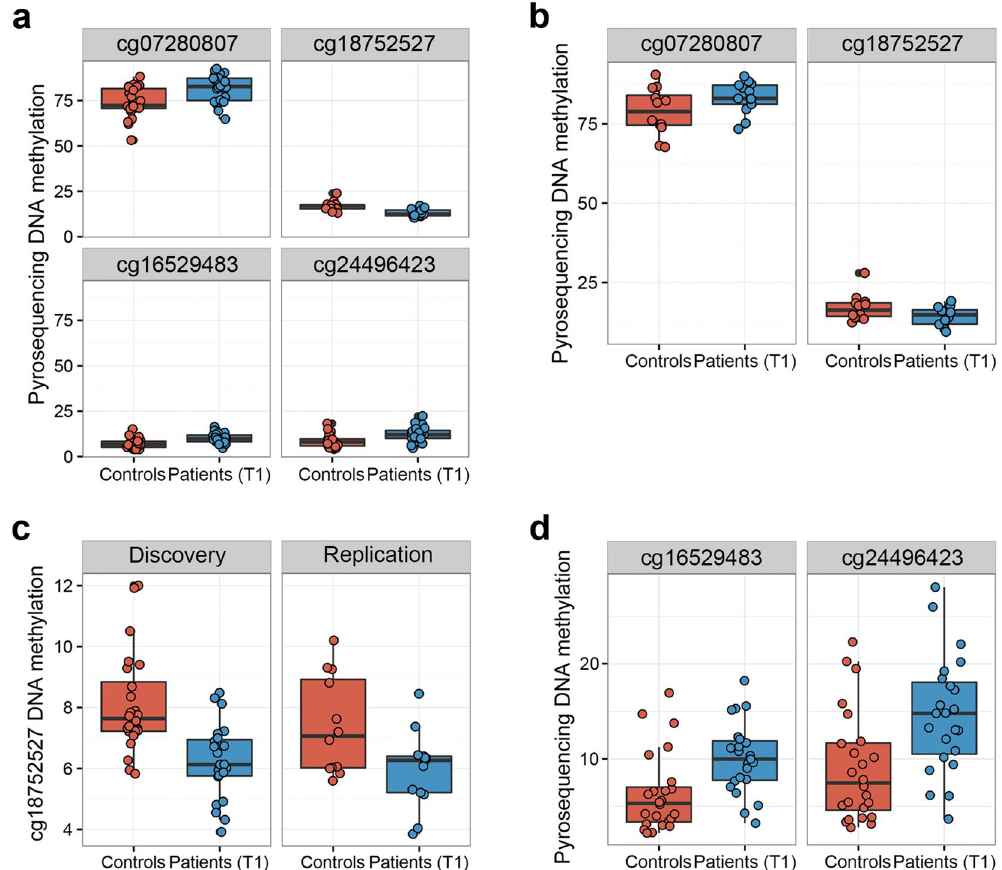
Figure 3. Validation and replication of top-ranking hits by pyrosequencing. ( a ) Boxplots showing differences in DNAm levels of discovery cohort T-cell samples as measured by pyrosequencing (FDR < 0.01, Student’s t-test). ( b ) Two top-ranked hits (cg07280807 and cg18752527) were verified as being differentially methylated in T-cell samples of the replication cohort (FDR < 0.05, one-sided t-test). ( c ) Verification of differential methylation of cg18752527 ( HECW2 ) in the discovery (left) and the replication cohort (right) in DNA derived from whole blood (FDR < 0.05, two-sided t-test). ( d ) Verification of cg16529483 and cg24496423 ( SRPK3 ) differential methylation in the discovery cohort in DNA derived from whole blood (FDR < 0.01, two-sided